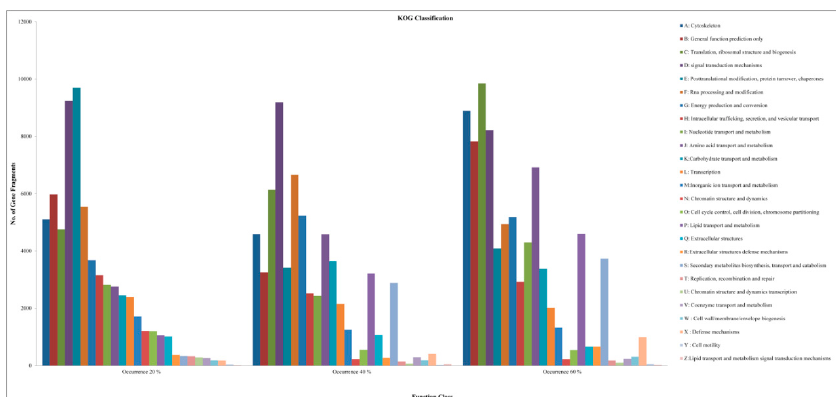
Figure 8. COG functional classifications of Labeo rohita fish fed with 20% (Control), 40% and 60% CHO. In total, 26 selected KOG categories were taken for the histogram. The x-axis indicates KOG categories on the right side of the histogram; the y-axis indicates the number of gene fragments in each functional cluster.